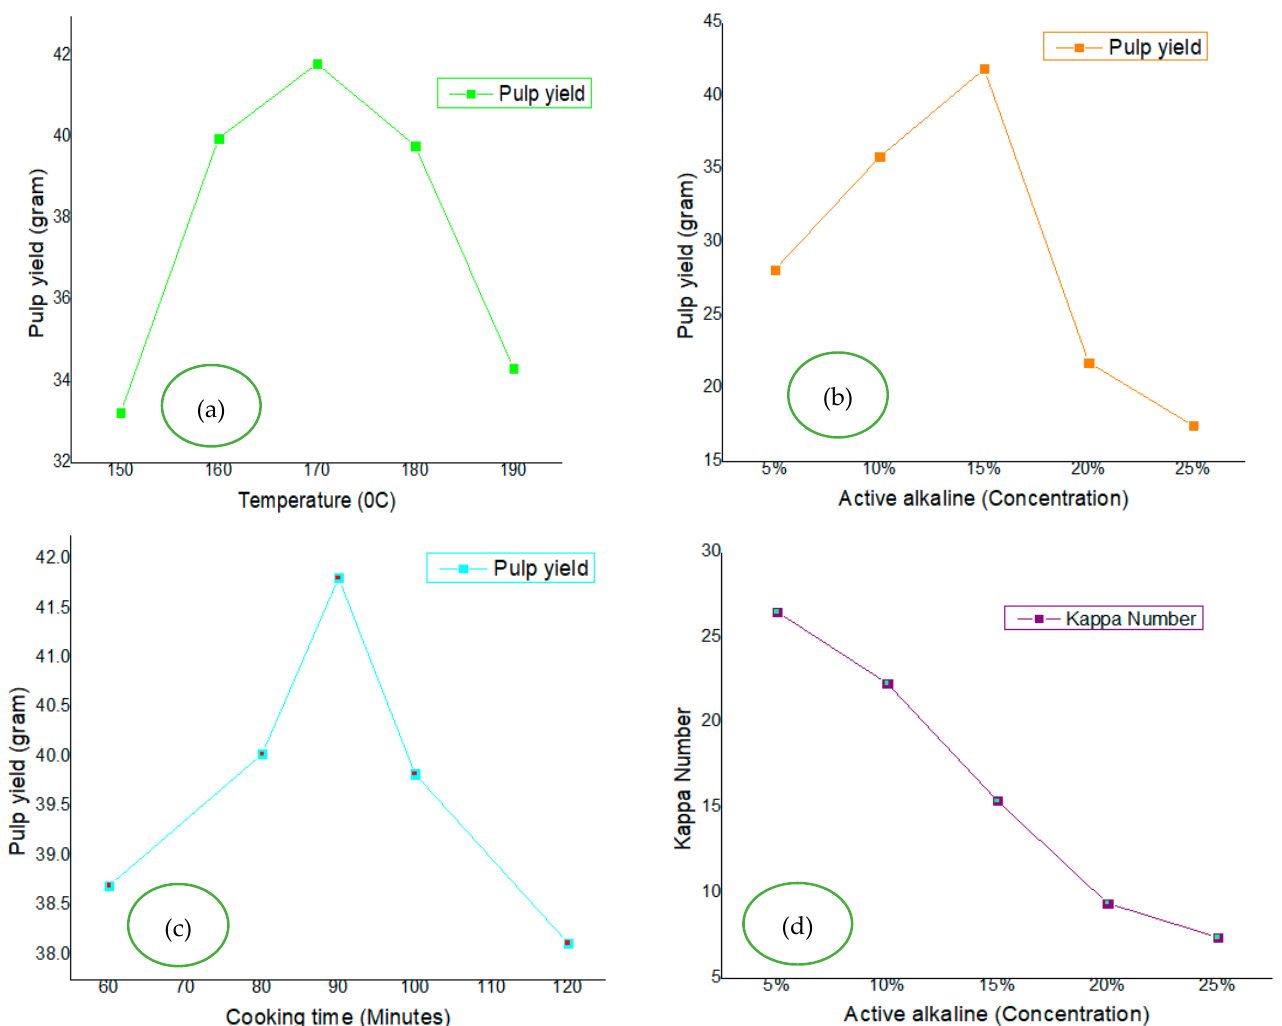
Figure 2. Temperature vs. pulp yield ( a ), active alkaline vs. pulp yield ( b ), cooking time vs. pulp yield ( c ), and active alkaline concentration vs. kappa number ( d ).